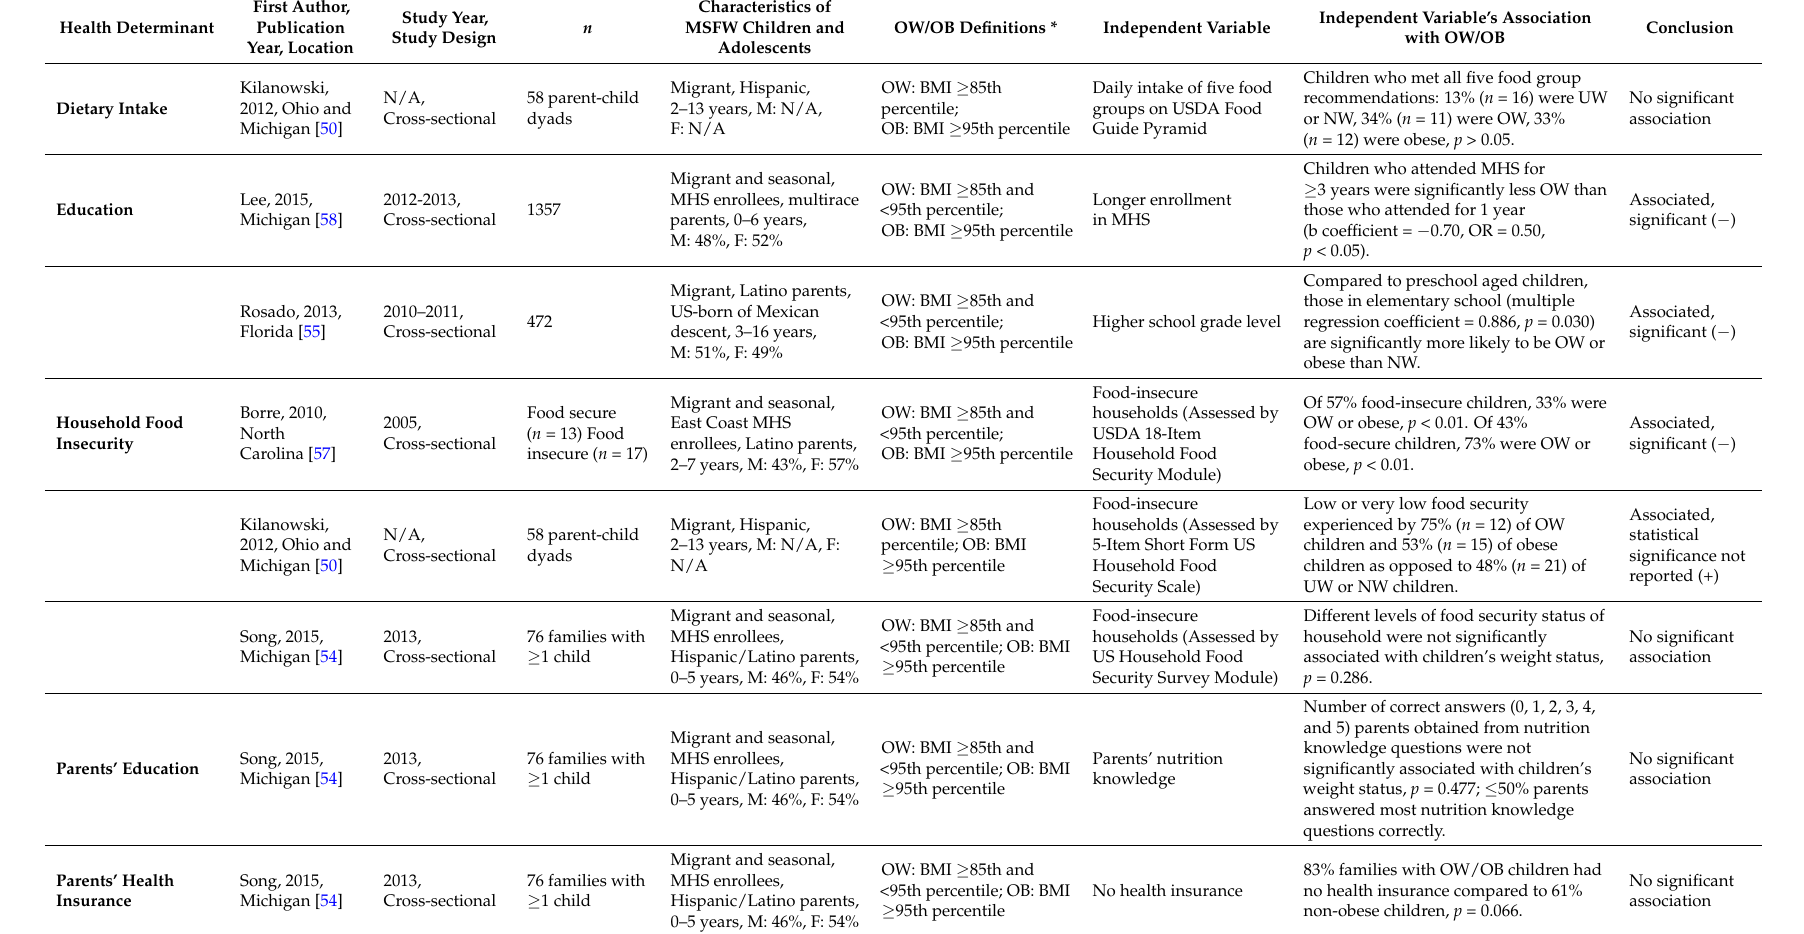
Table 2. Health determinants of overweight and